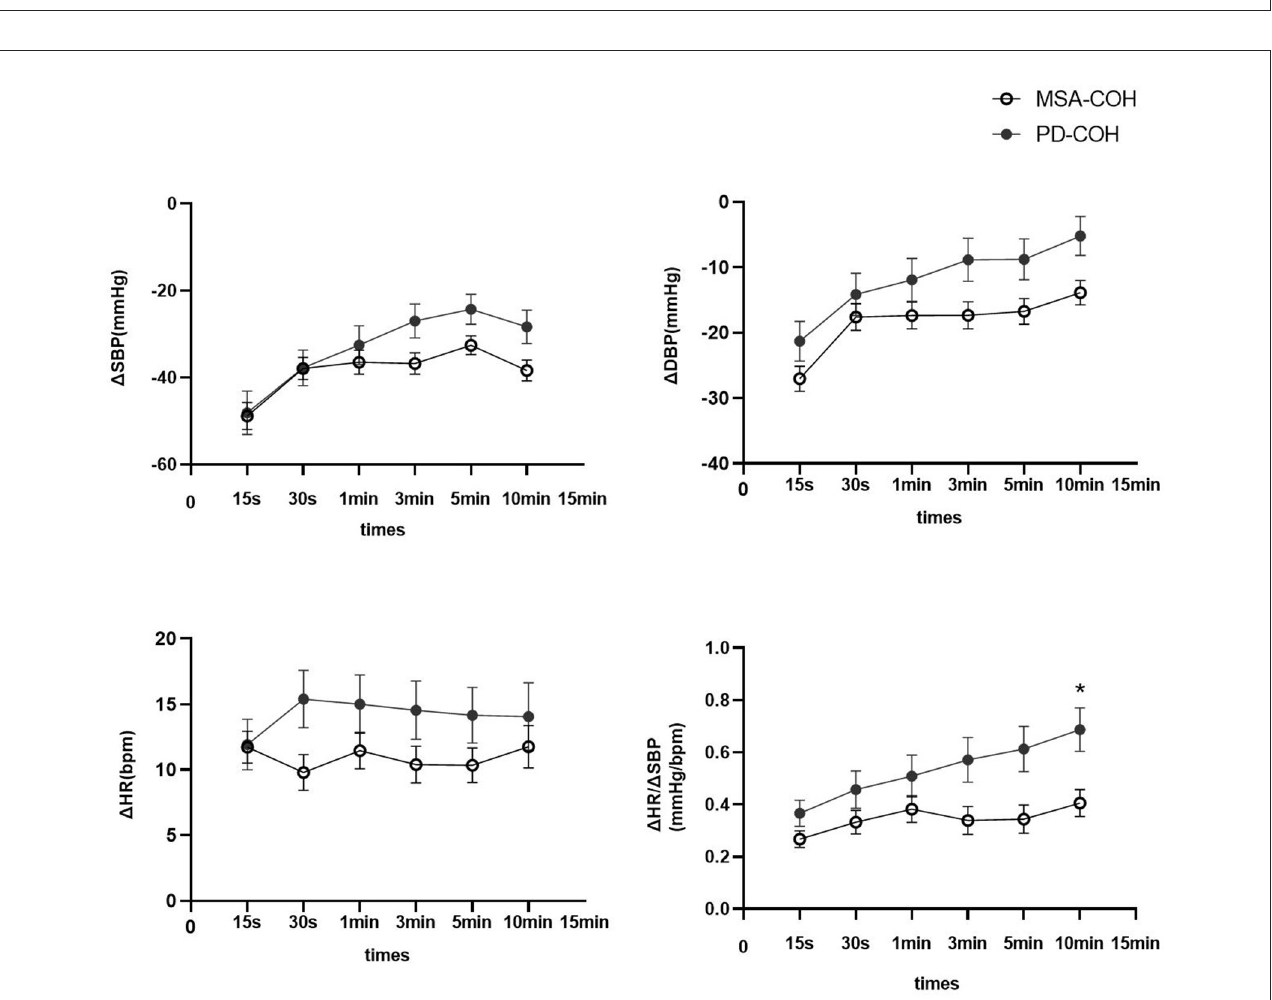
FIGURE2 1 SBP, 1 DBP, 1 HR, and 1 HR/ 1 SBP in PD and MSA groups with COH. Vertical lines are standard deviation. MSA-COH had lower 1 SBP, 1 DBP, 1 HR, and 1 HR/ 1 SBP than PD-COH. Statistical significance: * P < 0.05.